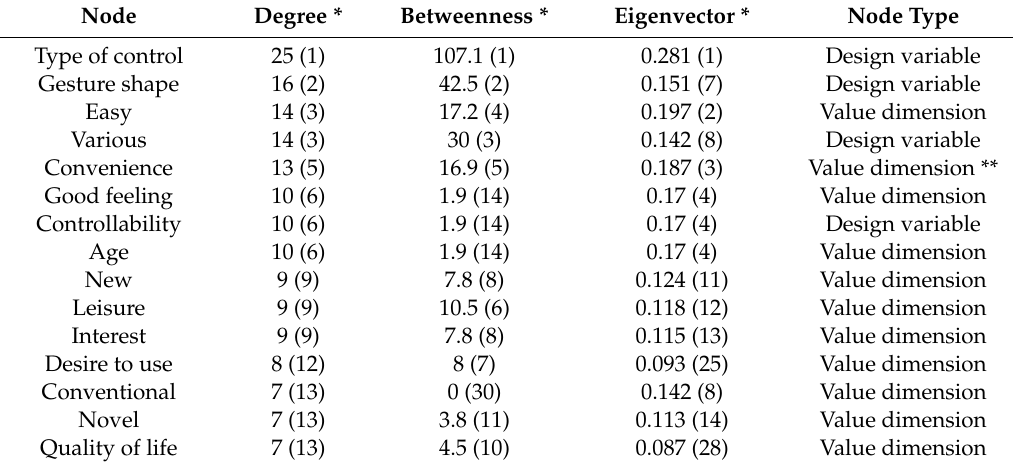
Table 3. Centrality of representative nodes associated with fun.